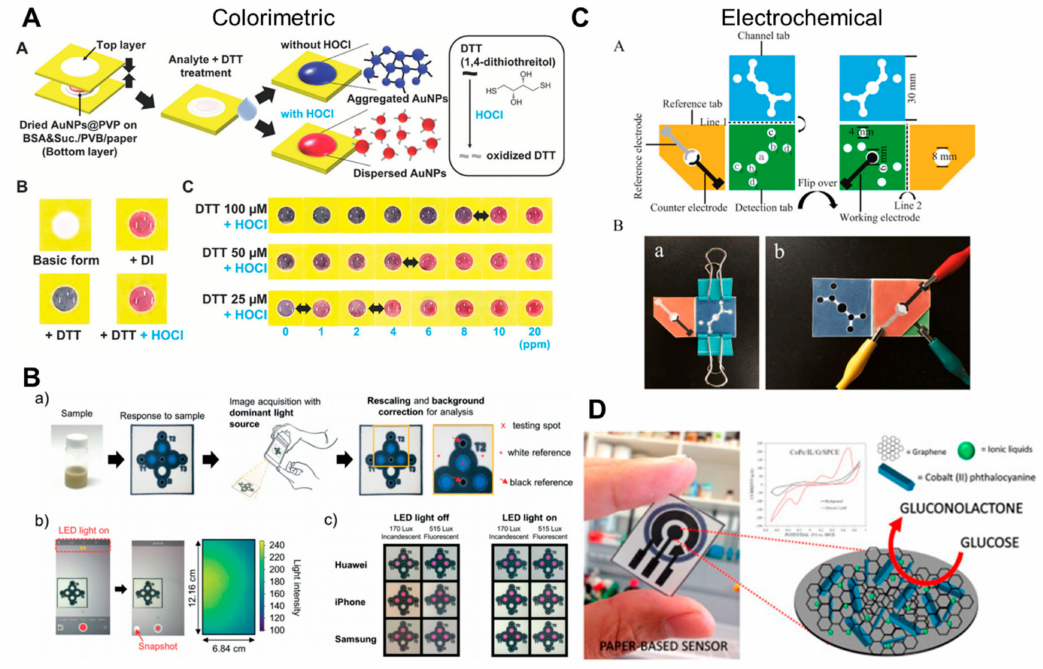
Figure 7. Detection techniques and recent applications of µ PADs. ( A ) Colorimetric sensing